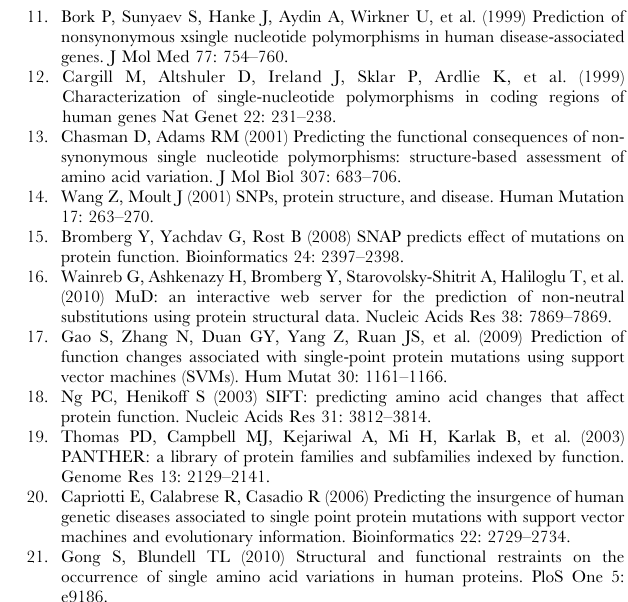
Figure S1 The feature selection curve in stepwise feature selection describes the performance change (in terms of MCC) of gradual inclusion of individual features to the trained classifiers. MCC_FSS (feature